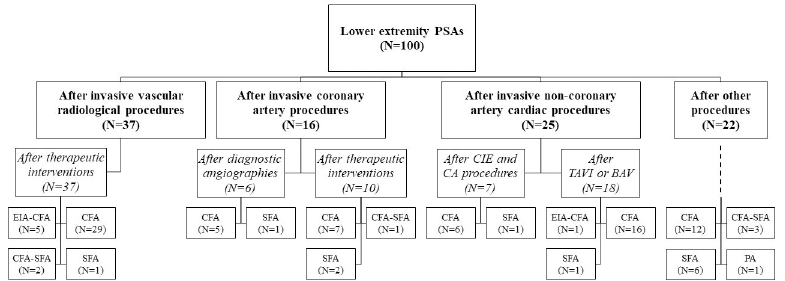
Fig 2. Lower extremity pseudoaneurysms. BAV , Balloon aortic valvuloplasty; CA , catheter ablation; CFA , common femoral artery; CIE , clinical intracardiac electrophysiological; EIA , external iliac artery; PA , popliteal artery; PSA , pseudoaneurysm; SFA , superficial femoral artery; TAVI , transcatheter aortic valve implantation.